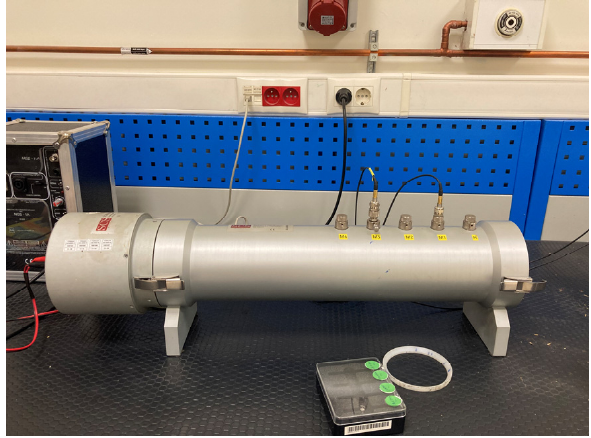
Figure 5. Kundt’s impedance tube at TSE (Tuzla, Istanbul).